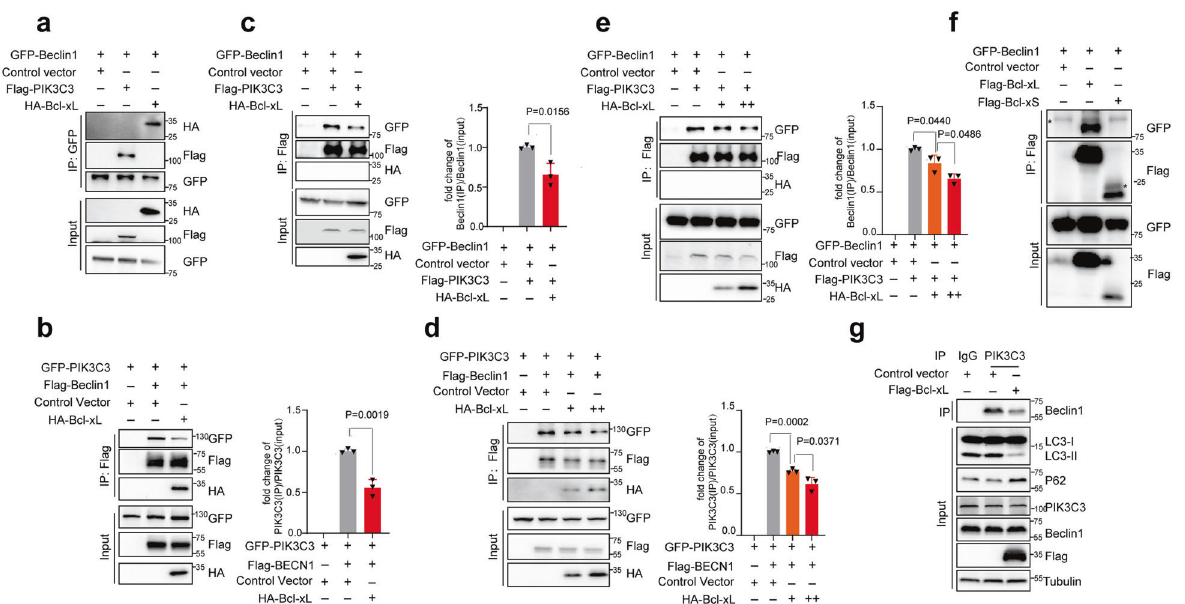
Fig. 4 SRSF1-mediated splicing of Bcl-xL inhibits autophagy through disruption of the formation of the autophagy initiation complex. 293 T cells were co-transfected with different combinations of Beclin1, PIK3C3, and Bcl-xL expression vectors in a – f . a 293 T cells were co- transfected with pEGFP-C1-Beclin1 and control vector; or pEGFP-C1-Beclin1 and Flag-PIK3C3 expression vector; or pEGFP-C1-Beclin1 and HA- Bcl-xL expression vector, respectively. Co-immunoprecipitation assay was carried out with anti-GFP antibody and the precipitated complexes were measured by western blot with anti-HA, anti-Flag, or anti-GFP antibodies. b 293 T cells were co-transfected with pEGFP-C1-PIK3C3 and control vector; or pEGFP-C1-PIK3C3 and Flag-Beclin1 expression vector; or pEGFP-C1-PIK3C3, and Flag-Beclin1 and HA-Bcl-xL expression vectors. c 293 T cells were co-transfected with pEGFP-C1-Beclin1 and control vector; or pEGFP-C1-Beclin1 and Flag-PIK3C3 expression vector; or pEGFP-C1-Beclin1, and Flag-PIK3C3 and HA-Bcl-xL expression vectors. d 293 T cells were co-transfected with pEGFP-C1-PIK3C3 and control vector; or pEGFP-C1-PIK3C3, and Flag-Beclin1 expression vector; or pEGFP-C1-PIK3C3, and Flag-Beclin1 vector, with increased amounts of HA- Bcl-xL expression vectors (100 ng and 500 ng) respectively. e 293 T cells were co-transfected with pEGFP-C1-Beclin1 and control vector; or pEGFP-C1-Beclin1, and Flag-PIK3C3 expression vector; or pEGFP-C1-Beclin1, and Flag-PIK3C3 expression vector, with increased amounts of HA-Bcl-xL expression vectors (100 ng and 500 ng) respectively. Three experiments were conducted respectively and the mean ± SD of the relative ratio of the precipitated Beclin1 or PIK3C3 were analyzed and plotted in b – e . f 293 T cells were co-transfected with pEGFP-C1-Beclin1 and control vector; or pEGFP-C1-Beclin1 and Flag-Bcl-xL expression vector; or pEGFP-C1-Beclin1 and Flag-Bcl-xS expression vector. Co- immunoprecipitation assay was carried out with anti-Flag M2 beads and the precipitated complexes were measured by Western blot with anti-HA, anti-Flag, or anti-GFP antibodies in b – f . g H1299 cells with overexpression of Bcl-xL were used for the immunoprecipitation experiments. Immunoprecipitation assay was performed with anti-PIK3C3 antibody and the endogenously precipitated complexes were measured by western blot assay with anti-Beclin1 antibody. The lysate was applied to examine the autophagy